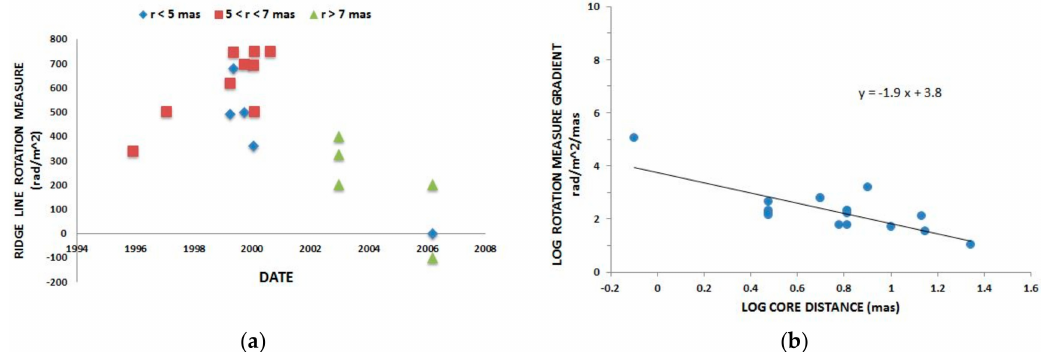
Figure 5. ( a ) Ridge line rotation measures as a function of observing epoch. Because the RM also varies with core-distance, we have split the measurements into three ranges of core-distance, as given in the legend. ( b ) The dependence of the transverse RM gradient on projected distance from the core measured in milliarcseconds. The regression line has a formal slope of − 1.9, but with a large and uncertain error because the scatter about that line is largely due to